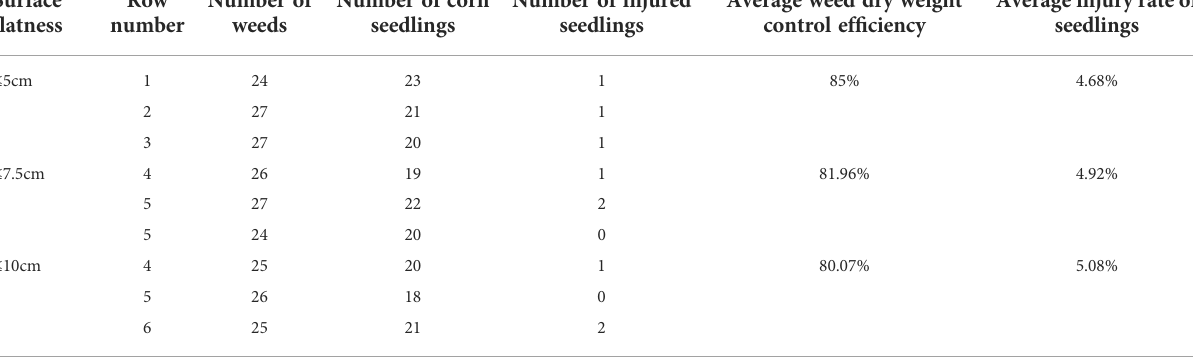
TABLE 4 Field weeding effect of weeding robot prototype. Surface fl